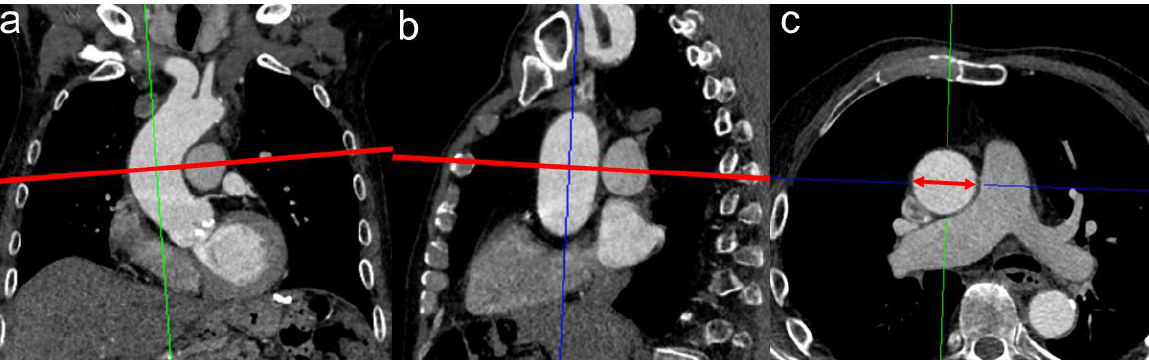
Figure 2. Measurement of the tubular ascending aorta at the level of the pulmonal artery bifurcation. Corrected axial vessel diameter was established using the multiplanar reconstruction plug-in of Deep Unity Diagnostics. The ascending aorta was manually corrected perpendicular to its centerline in coronal ( a ) and sagittal reconstruction ( b ). The obtained corrected axial aortic cross-section was measured (red double-headed arrow in c ), and the widest diameter was used as maximum diameter.